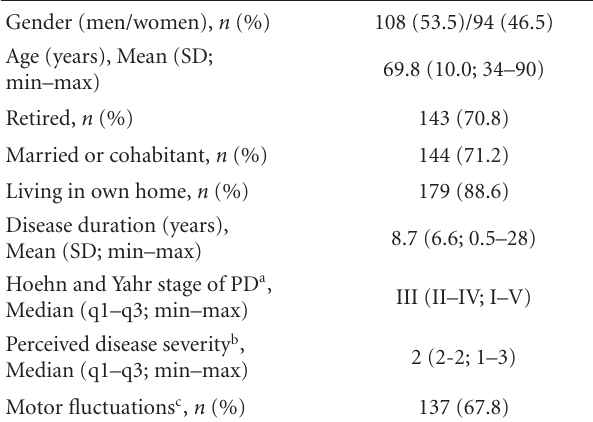
Table 1: Sample characteristics ( n =